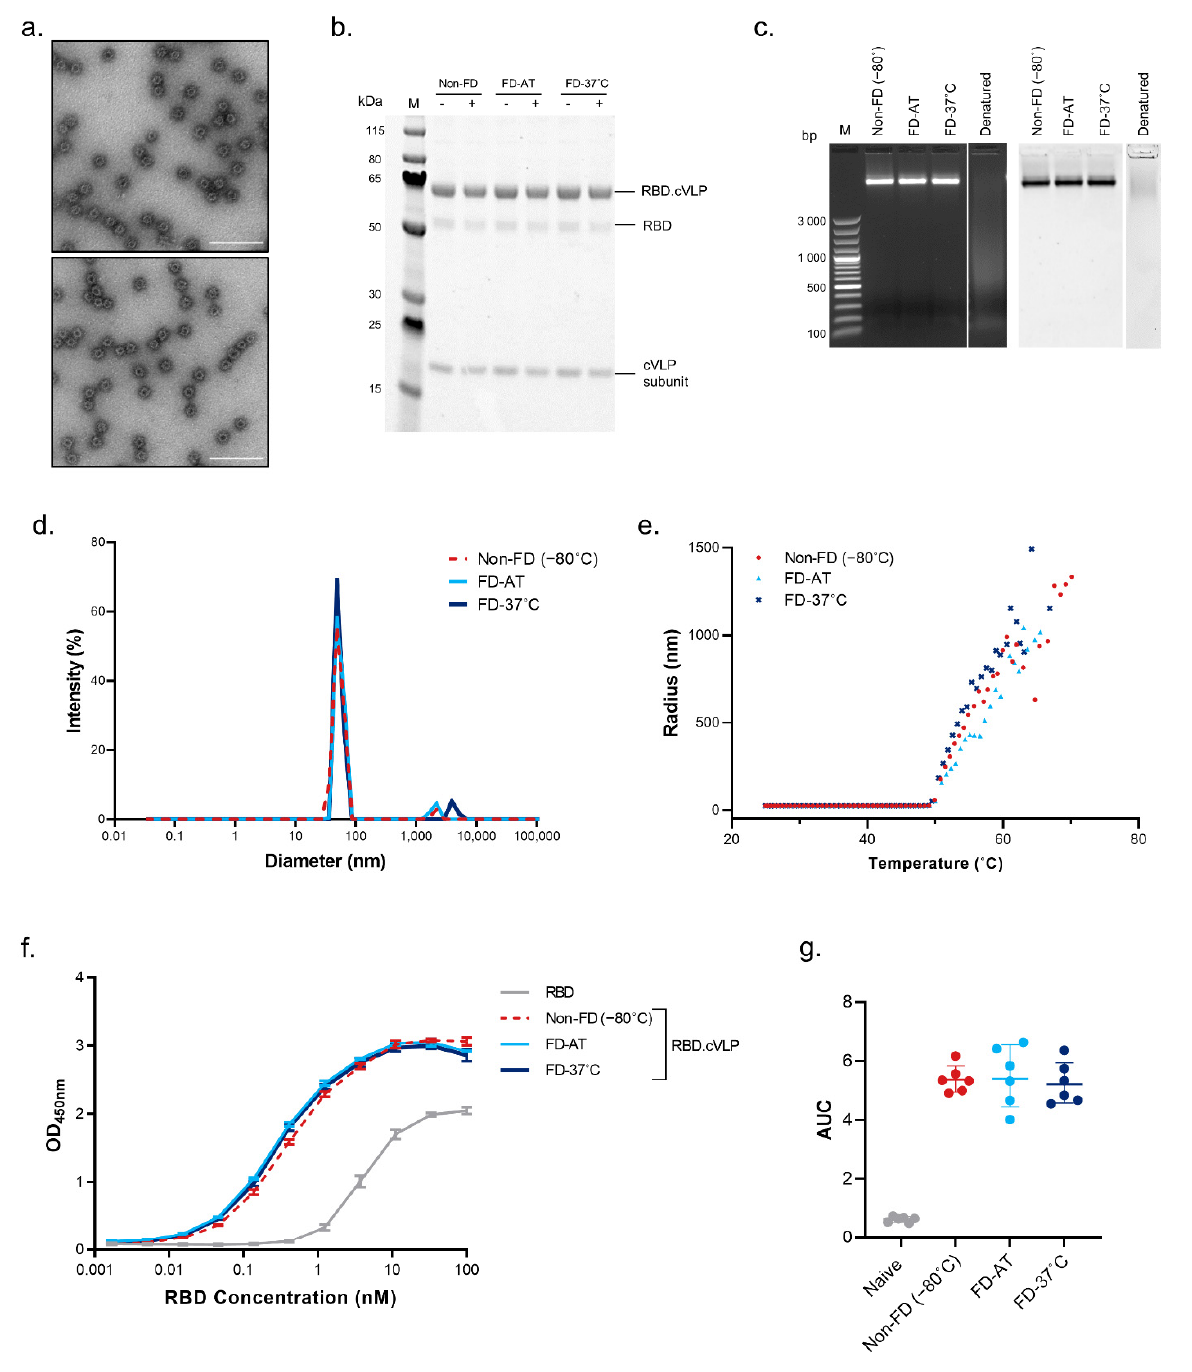
Figure 3. RBD-cVLP (SARS-CoV-2) vaccine maintains its stability and immunogenicity after freeze- drying. RBD-cVLP vaccine was freeze-dried and stored at ambient temperature (FD-AT) or 37 ◦ C (FD-37 ◦ C) for 1 week ( A ) or 2 months ( B – G ). The stability of freeze-dried and reconstituted material was compared to a frozen, non-freeze-dried (non-FD ( − 80 ◦ C)) reference sample. ( A ) Negative stain transmission electron microscopy (TEM) images of a non-freeze-dried RBD-cVLP reference sample (top panel) and freeze-dried RBD-cVLP (bottom panel). Scale bar represents 200 nm. ( B ) Representa- tive reduced SDS-PAGE analysis showing non-freeze-dried and freeze-dried RBD-cVLP (stored at ambient temperature or 37 ◦ C) before (-) and after (+) centrifugation. ( C ) Agarose gel electrophoresis stained with ethidium bromide (left) and Coomassie brilliant blue (right). Native non-FD and FD samples were run in parallel to a denatured reference sample. ( D ) Overlay of DLS analysis of non-FD and FD RBD.cVLP. ( E ) Thermal stability of freeze-dried RBD.cVLP. DLS was used to measure